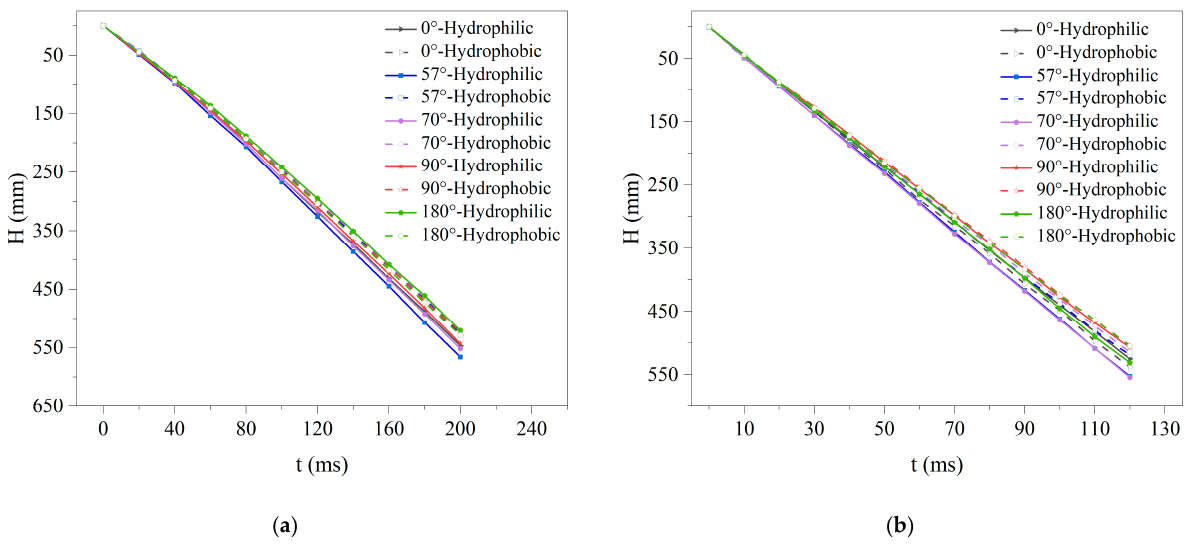
Figure 27. Hydrophilic/hydrophobic model’s ballistic curve. ( a ) The initial velocity v = 2.2 m/s. ( b ) The initial velocity v = 3.95 m/s.